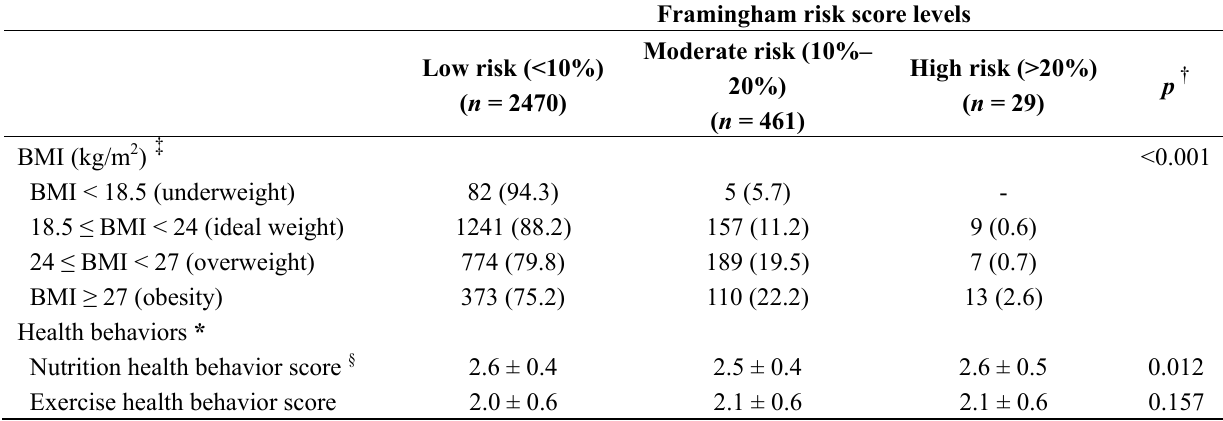
Table 2. Comparison of FRS levels on BMI using chi-square test, and on health behaviors using one-way ANOVAs and post-hoc